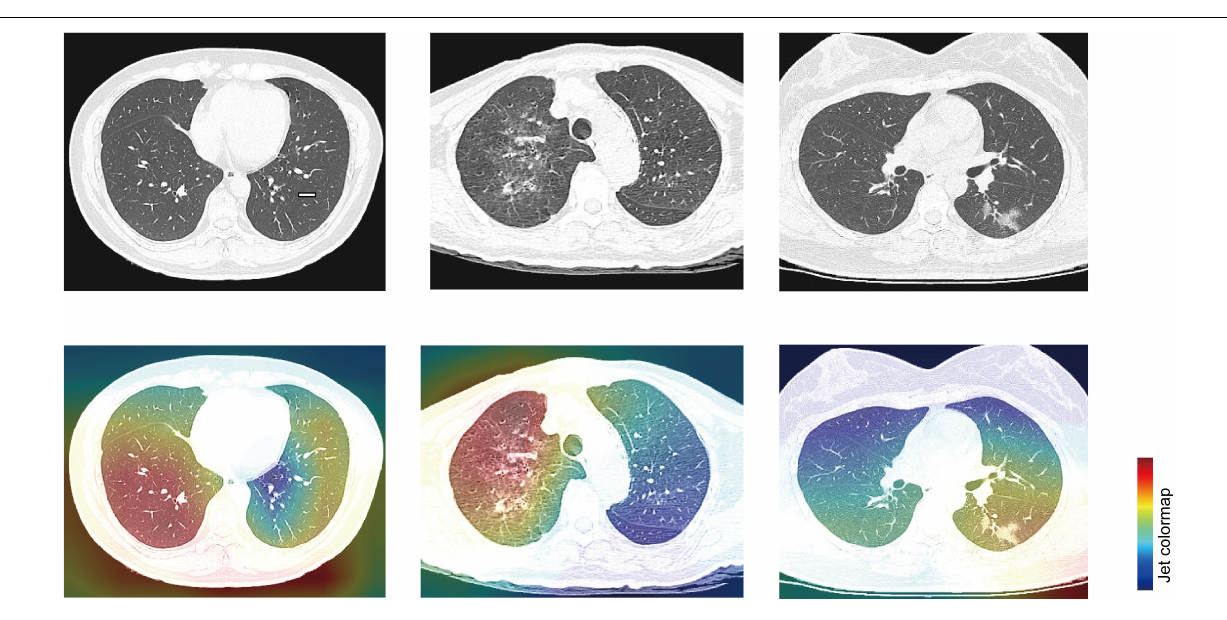
FIGURE 3 | Typical examples of chest CT images of patients and visual features correlated to classification. The first row demonstrates the original images of patients with normal control, other pneumonia, and COVID-19, respectively. The second row demonstrates heat maps corresponding to the first row, showing highly relevant areas of